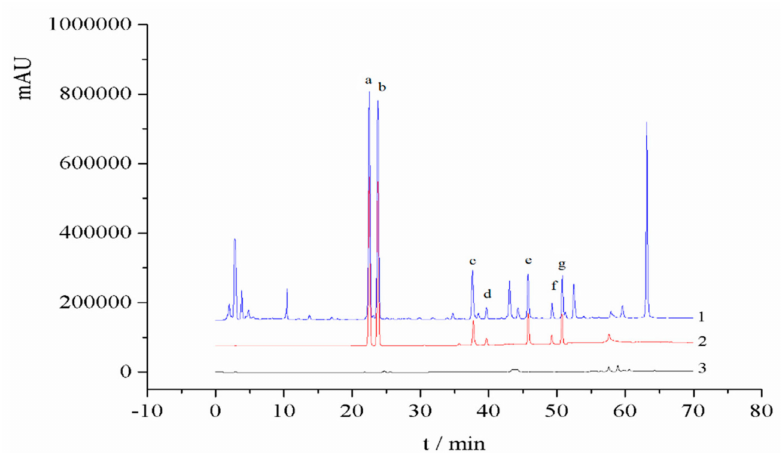
Figure 5. HPLC chromatograms of the (1) sample solution, (2) standard solution, (3) and blank solvent, namely: ( a ) psoralen, ( b ) isopsoralen, ( c ) neobavaisoflavone, ( d ) bavachin, ( e ) psoralidin, ( f ) isobavachalcone, and ( g )